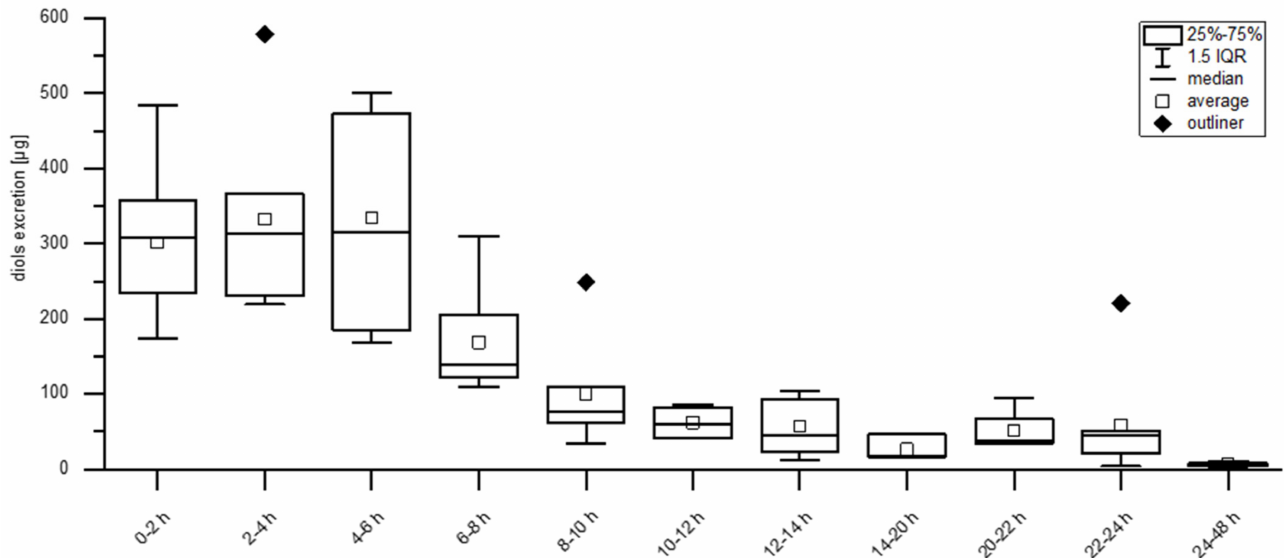
Figure 6. Erythro - and threo -asarone diols (diols) excretion kinetic [ µ g] of ten participants over a period of 48 h. Excretion is classified in two-hour blocks, except for the night hours (14–20 h) and the last 24 h, because the concentrations of the metabolites were mostly under the Limit of Quantification